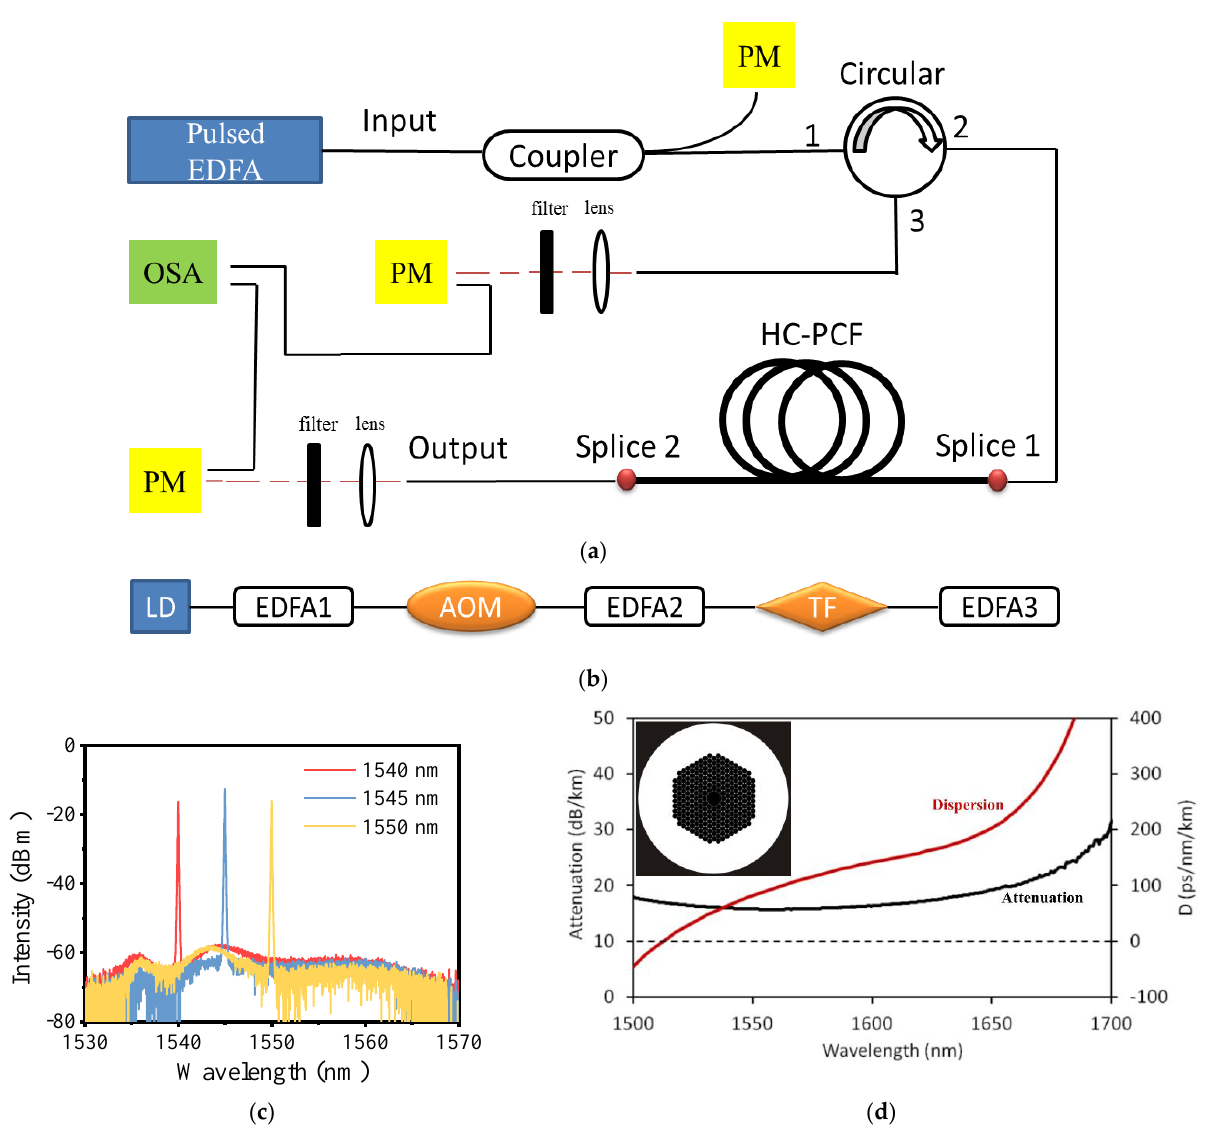
Figure 1. ( a ) Experimental setup: EDFA: Erbium doped fiber amplifier, PM: power meter, OSA: optical spectrum analyzer. ( b ) The structure of the pump source. TF: tunable filter. ( c ) The output spectrum of the pump source at maximum power. ( d ) The attenuation and dispersion curves of the HC-PCF, the insert: the optical microscope image of its cross section.